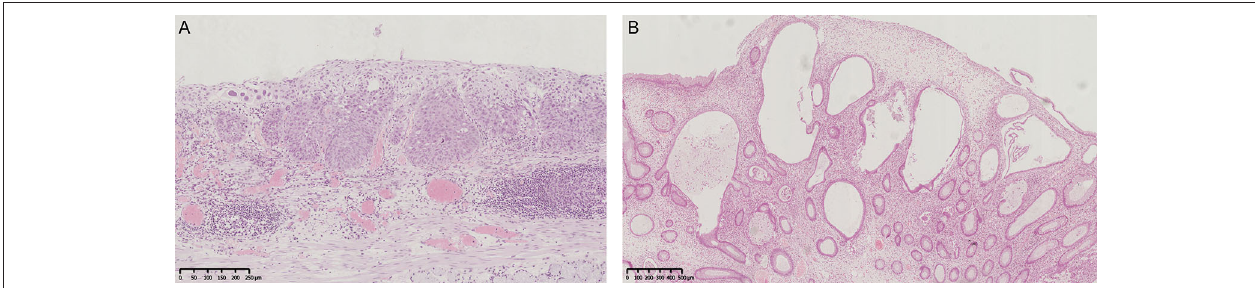
FIGURE 3 | Histological images. (A) Esophageal lesion. Squamous cell carcinoma. Atypia cells with abundant eosinophilic cytoplasm and keratinization were observed. Mt, type Paris 0-IIb, 22 × 10mm, SCC, pT1a-LPM, INFa, ly0, v0, pHM0, pVM0, pR0, pCurA (Middle third of esophagus, flat type, size: 22 × 10mm, squamous cell carcinoma, tumor invades lamina propria mucosae, infiltration pattern A, no lymphatic invasion, no venous invasion, clear horizontal margin, clear vertical margin, no residual tumor, complete removal of the tumor). (B) Colon juvenile polyp. Prominent, cystically dilated glands and inflammatory stroma were